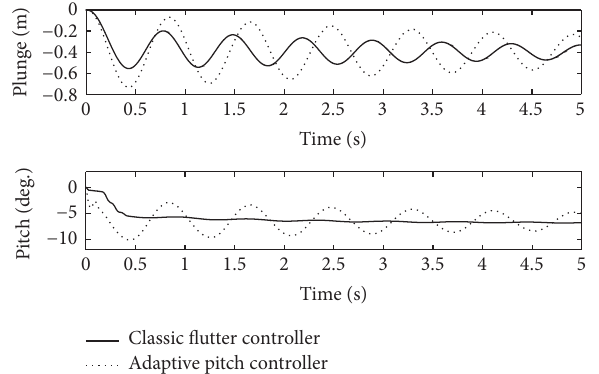
Figure 7: System responses with classic flutter controller and adaptive pitch controller at moderate stall flutter case.